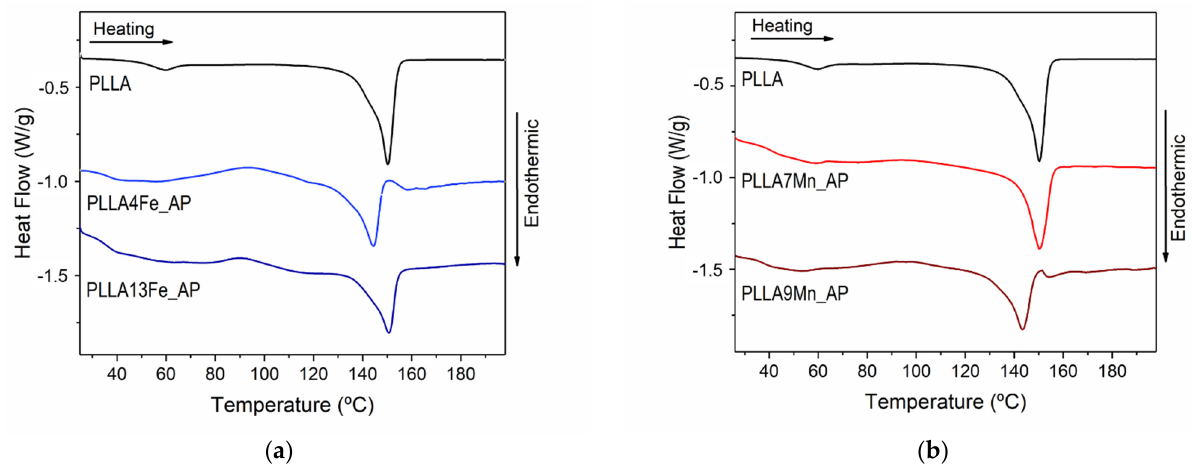
Figure 6. DSC scans of ( a ) PLLA and PLLA reinforced with 4.1 and 12.7 wt% of γ -Fe 2 O 3 MNPs and ( b ) PLLA and PLLA reinforced with 7.4 and 8.7 MnFe 2 O 3 MNPs.